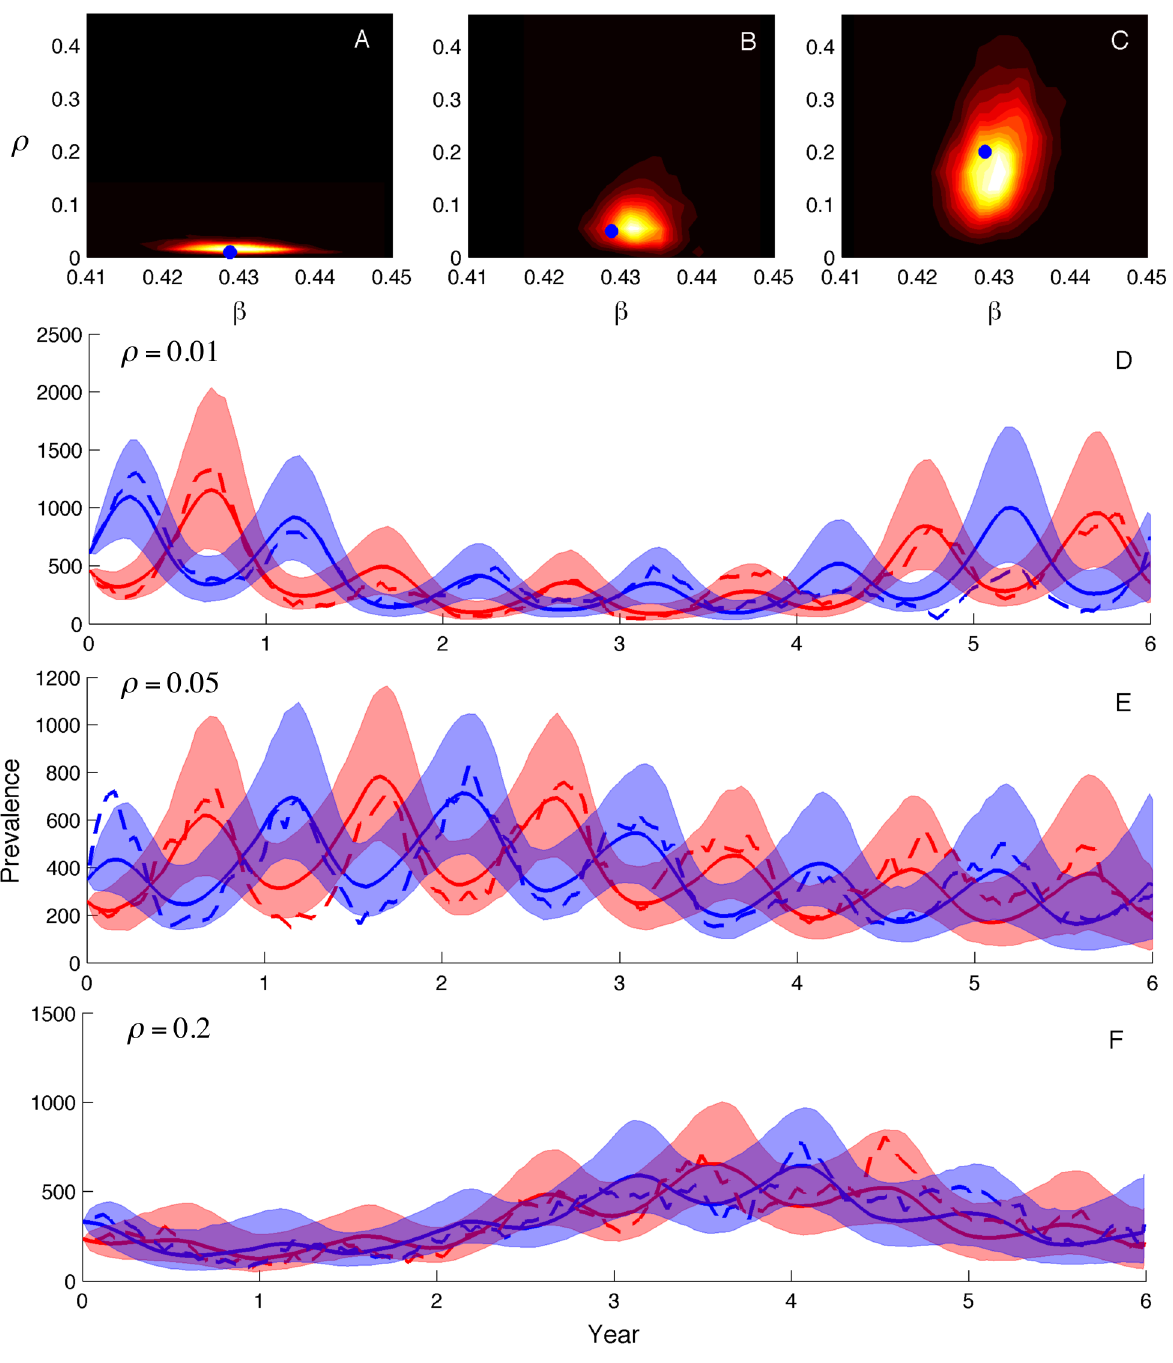
Figure 4. Parameter and prevalence estimates for the two-population model. Mixing rates between the two populations were varied from low ( r ~ 0 : 01 ), medium ( r ~ 0 : 05 ) to high ( r ~ 0 : 2 ). (A–C) Joint posterior densities for the transmission rate b and the mixing parameter r . (D–F) Prevalence estimates for the two populations with the 95% credible intervals shaded and the posterior medians shown as solid lines. Dashed lines show the true prevalence. Initial conditions for the number of susceptible and infected individuals in each population were fixed at their true values for these simulations.